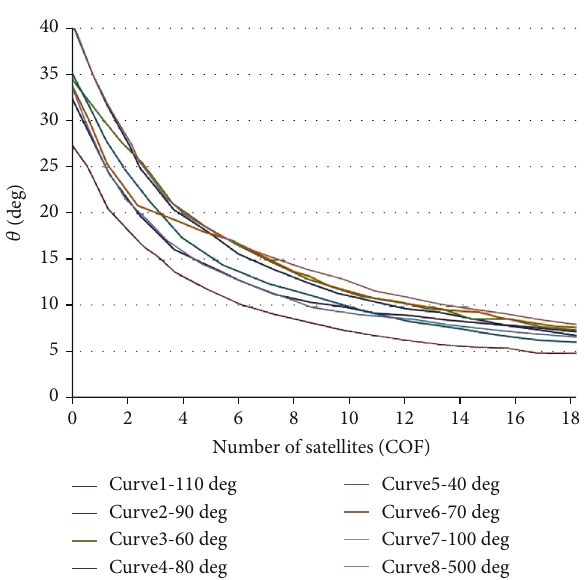
Figure 8: Results of COF constellation.